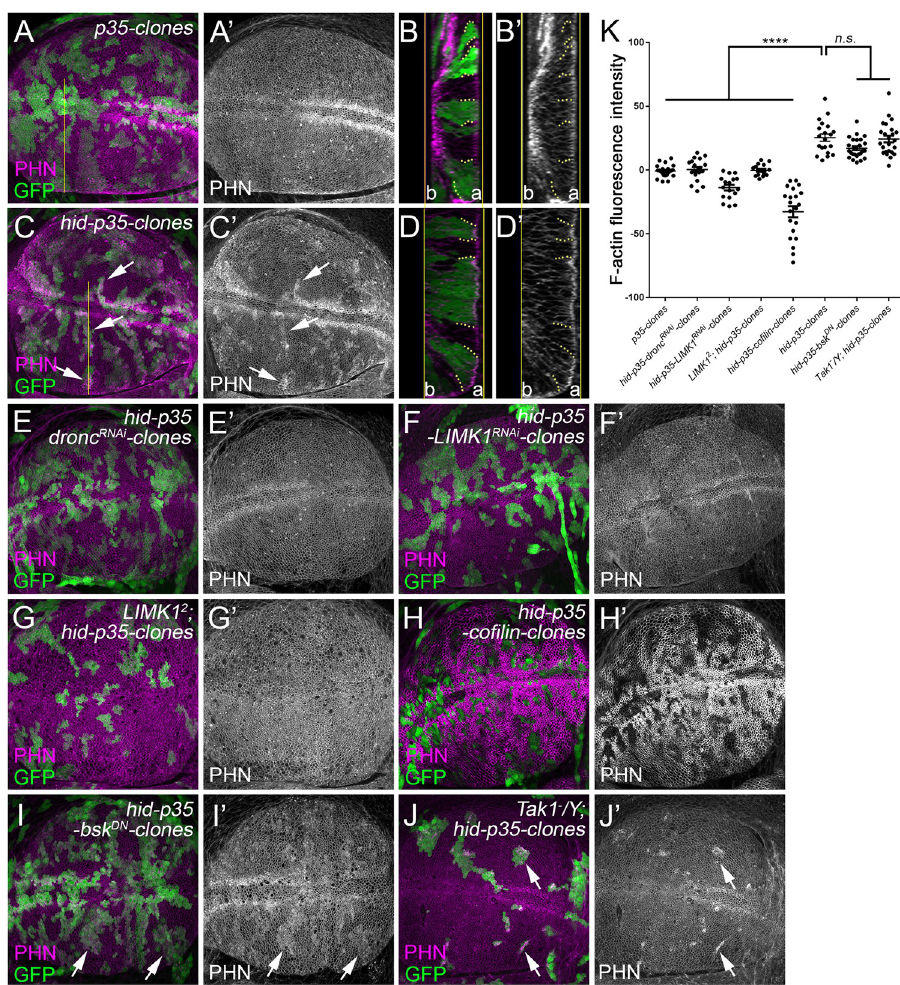
Fig 4. F-actin accumulation in hid-p35 clones depends on LIMK1 and Cofilin, but not JNK signaling. (A-J’) Late 3 rd instar wing discs with 48-hour old mosaic clones positively marked by GFP. Phalloidin (PHN, magenta in A-J and grey in A’-J’) labels F-actin. Images of the apical side of the discs are shown in A, C and E-J. B and D show the cross sections corresponding to the yellow lines indicated in A and C, respectively. The apical (a) and basal (b) surfaces of these cross sections are as indicated. Compared to the control clones expressing P35 only (A-B’), simultaneous expression of hid and p35 ( hid-p35 clones) leads to an accumulation of F-actin apically in the clones (arrows in C, C’ and clones highlighted by yellow dotted lines in D, D’). This F-actin accumulation in hid-p35 clones is suppressed by expression of dronc RNAi (E, E’), LIMK1 RNAi (F, F’) or in LIMK1 2 hemizygous mutants (G, G’). Expression of cofilin in the hid-p35 clones further reduces the level of F-actin (H, H’). In contrast, F-actin accumulation persists the hid-p35 clones with expression of a dominant negative mutant of bsk ( bsk DN , I, I’, arrows) or in a Tak1 hemizygous null mutant background (J, J’, arrows). (K) Quantification of the F-actin signal intensity in the representative clones of the indicated genotypes in the wing disc pouches. Images of the apical side of the discs were used. Compared to the p35 clones, the DHE signals are significantly ( ���� p < 0.0001) increased in the hid-p35 clones. This increase is significantly ( ���� p < 0.0001) reduced in response to expression of SOD , cofilin or in LIMK1 2 mutants. In contrast, expression of bsk DN or Duox RNAi has no significant (n.s.)